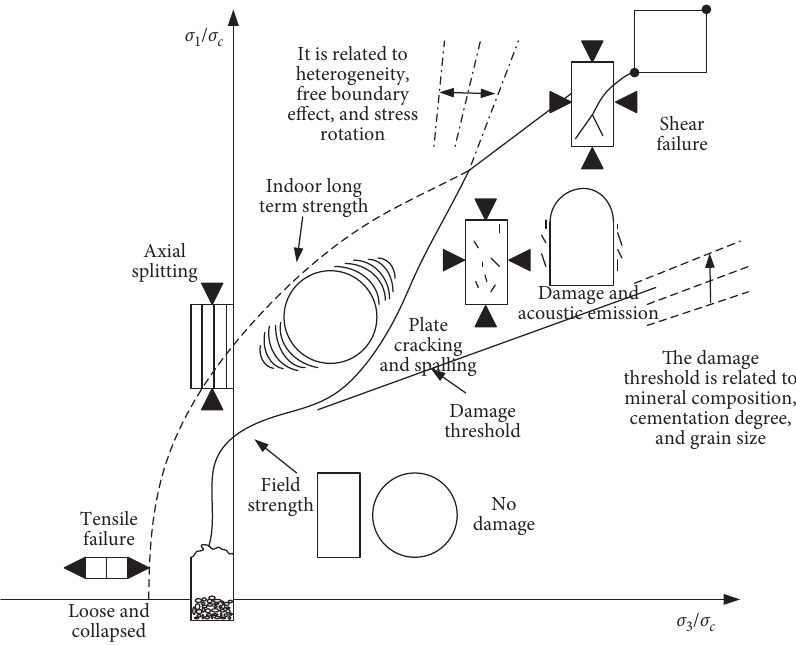
Figure 1: The empirical-theoretical criterion curve of excavation failure of high-stress rock mass.